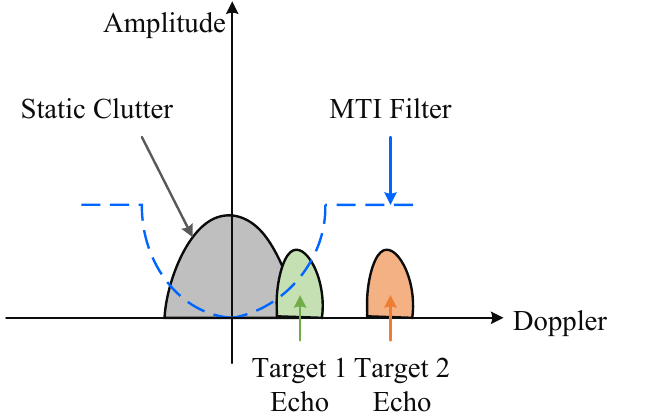
Figure 7. Schematic diagram of MTI filtering. It shows the relationship between filter notch and static clutter, and two targets in the Doppler